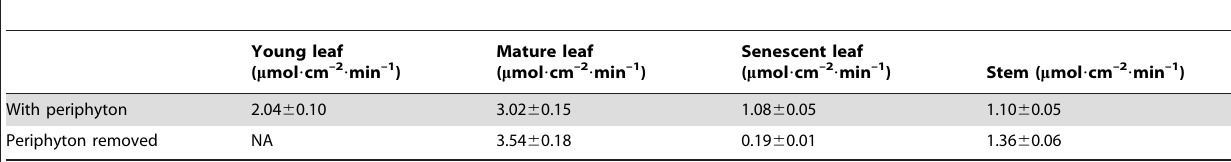
Table 2. The estimated O 2 fluxes ( m mol ? cm –2 ? min –1 ) through the broad diffusive boundary layer associated to the surface of Potamogeton malaianus according to Fick’s first law (n=3)